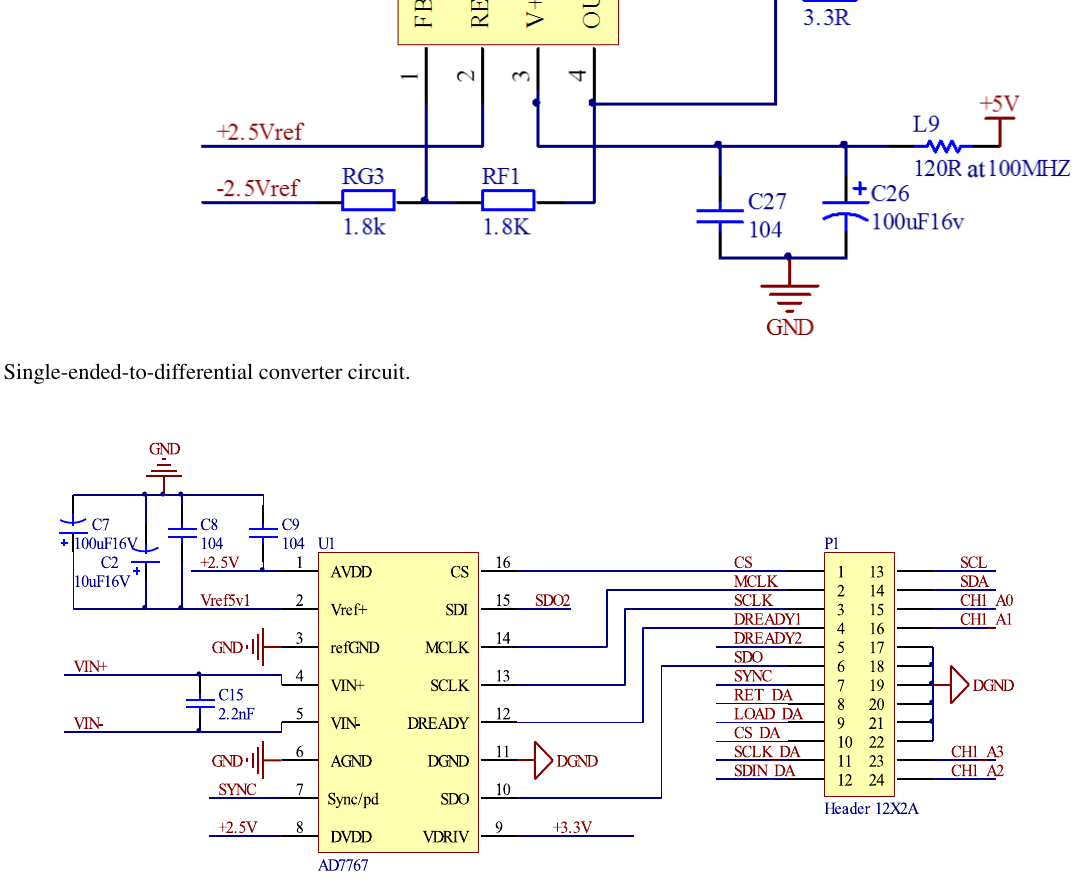
Figure 6. Analog-to-digital converter